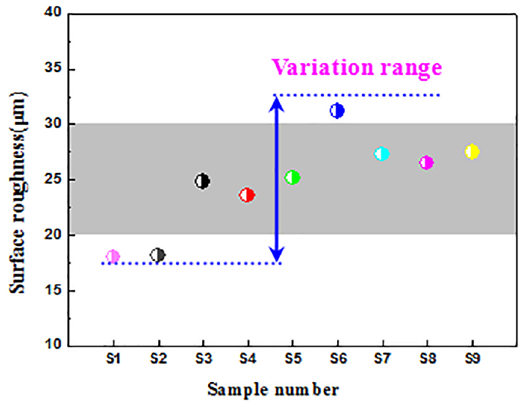
Figure 15. Comparison of surface roughness of Ni-Al coatings for